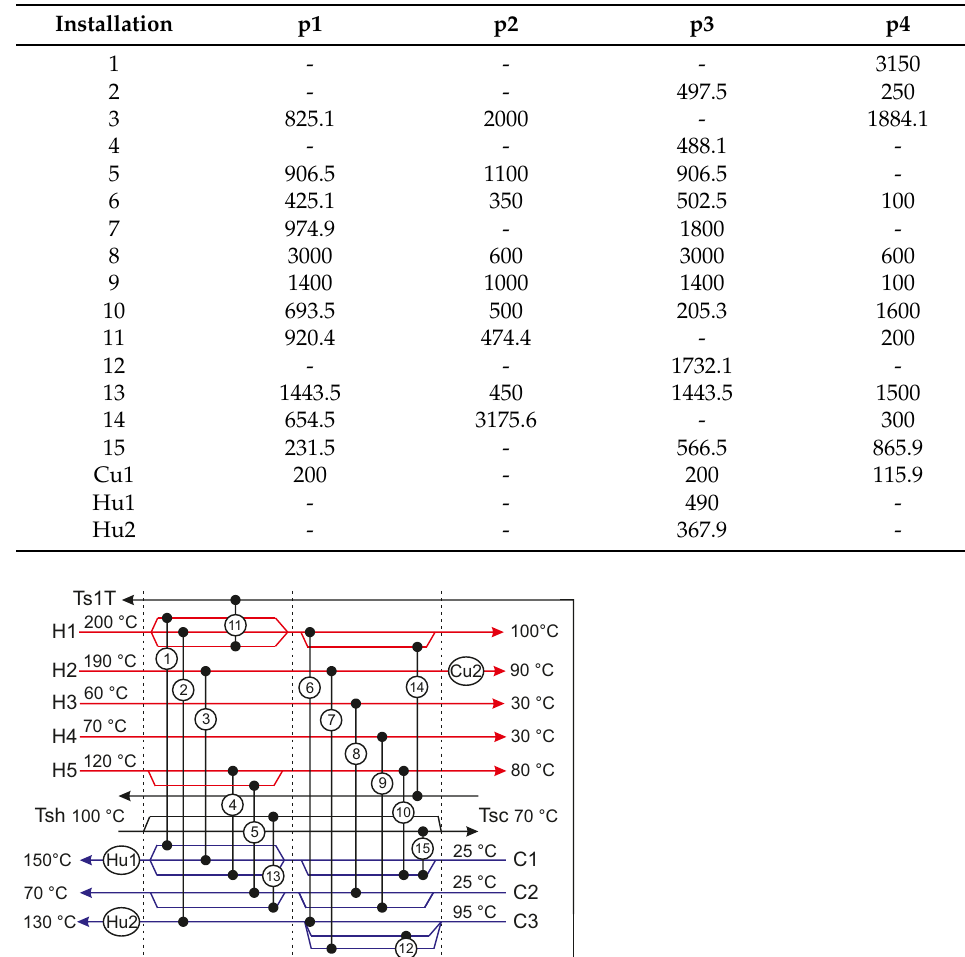
Table 6. Heat Flows and P el results with HP and ST options case 1 (kW).